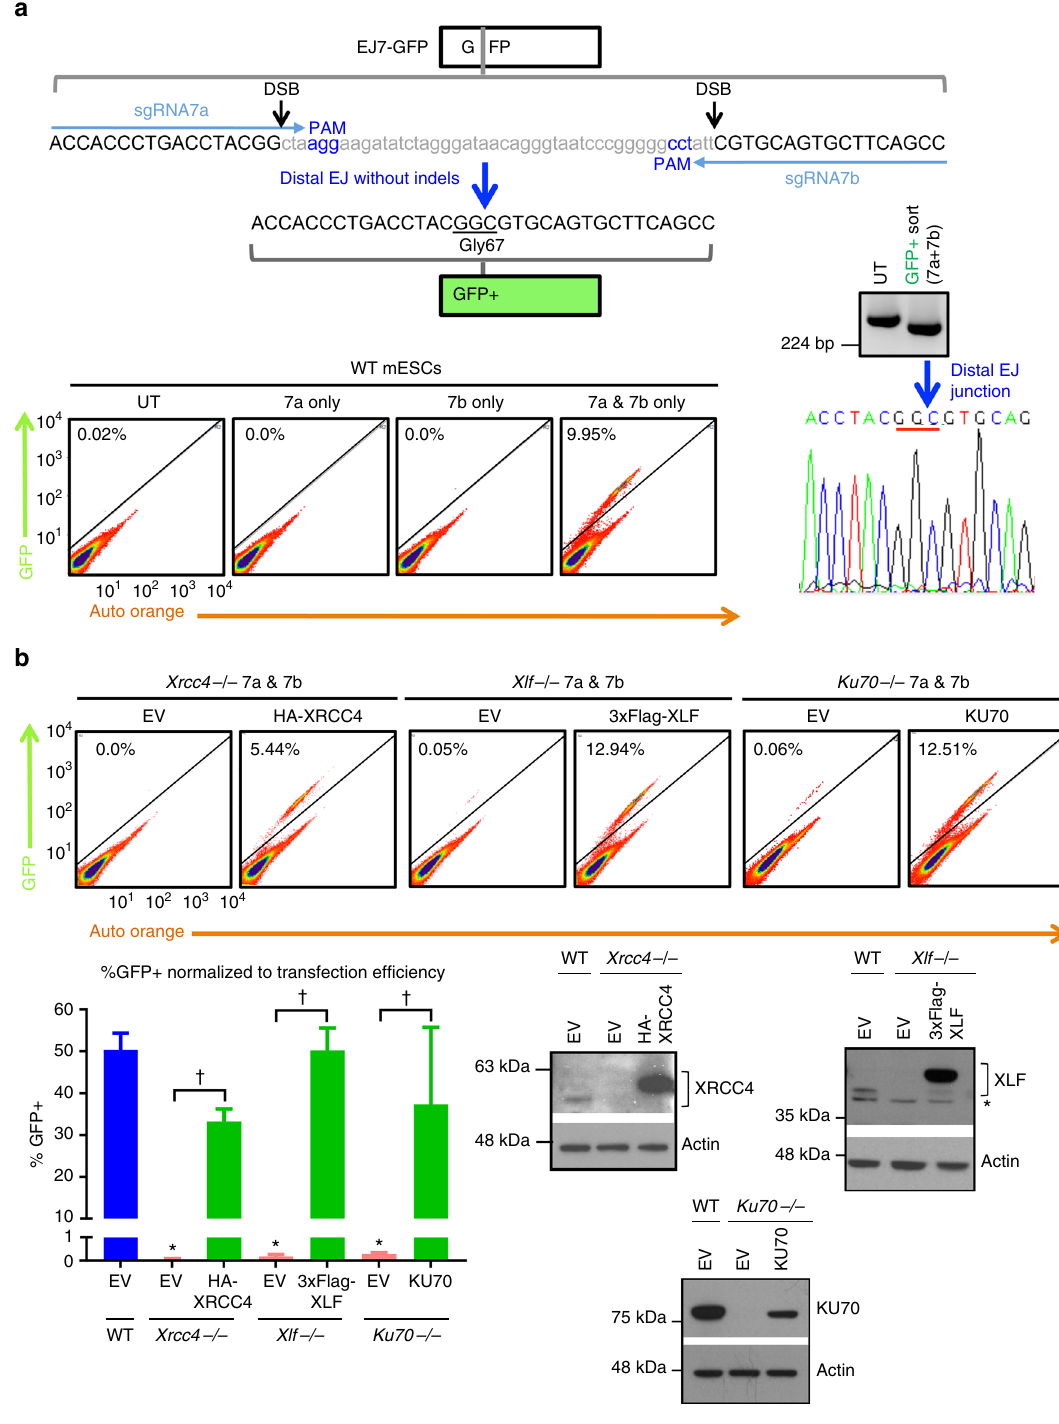
Fig. 1 Distal end joining (EJ) without causing indels requires C-NHEJ. a Shown is the EJ7-GFP reporter assay for distal EJ without indels. Representative fl ow cytometry plots are shown for WT mESCs with EJ7-GFP integrated into the Pim1 locus, which were untransfected (UN), or transfected with expression plasmids for Cas9 and sgRNAs (7a, 7b, or both). Shown is the ampli fi cation product and chromatogram from GFP + WT mESCs to con fi rm the expected repair product. b Distal EJ without indels requires XRCC4, XLF, and KU70. WT, Xrcc4 − / − , Xlf − / − , and Ku70 − / − mESCs with EJ7-GFP integrated into the Pim1 locus were transfected with expression vectors for Cas9 and the 7a and 7b sgRNAs, in the presence of a control empty vector (EV) or a complementation vector. Shown are representative fl ow cytometry plots, as well as the frequency of GFP + cells for these transfections, normalized to transfection ef fi ciency. N = 6, error bars represent standard deviation (s.d.). * p < 0.0001, mutant cell lines vs. WT using an unpaired t -test, with the Holm- Sidak correction (for multiple comparisons). † p ≤ 0.0006, EV vs. complemented compared using an unpaired, two-tailed t -test. Also shown are immunoblots con fi rming expression of XRCC4, XLF, and